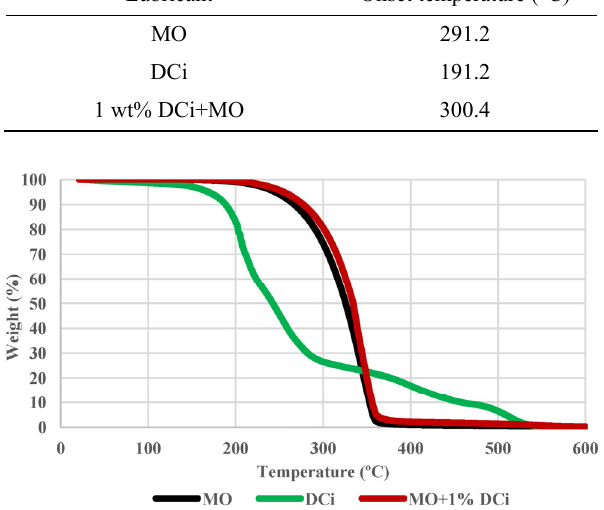
Fig. 4 Experimental TGA for MO, DCi, and 1 wt% DCi+MO.